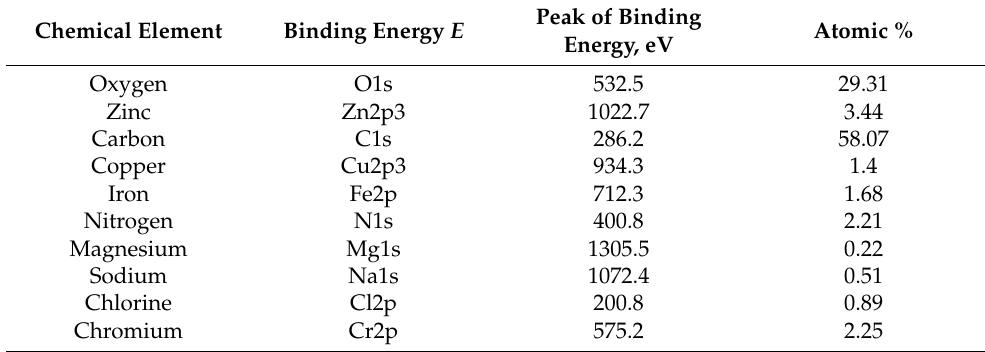
Table 6. X-ray peaks of the X10CrNiTi18-10 (12kH18N10T) steel sample machined surfaces.